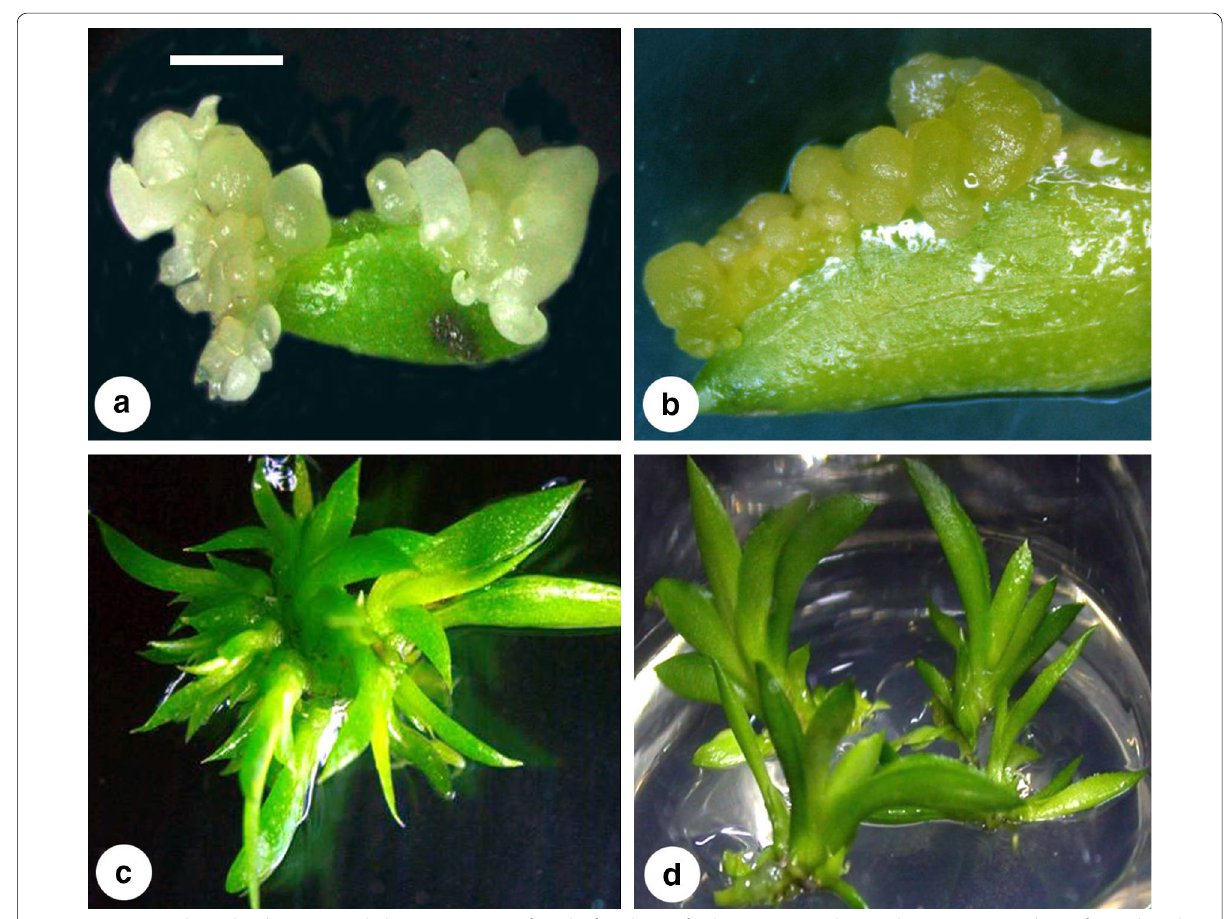
Fig. 2 Somatic embryo development and plant regeneration from leaf explants of Tolumnia Louise Elmore ‘Elsa’. a somatic embryos formed on the leaf tip and the cut end of a explant ( Scale bar 3.5 mm); b somatic embryos formed on the edge of the adaxial surface of the leaf explant ( Scale bar 2 mm); c multiple shoots developed from leaf‑derived somatic embryos ( Scale bar 5 mm); d plantlets converted from leaf‑derived somatic embryos ( Scale bar 2.5